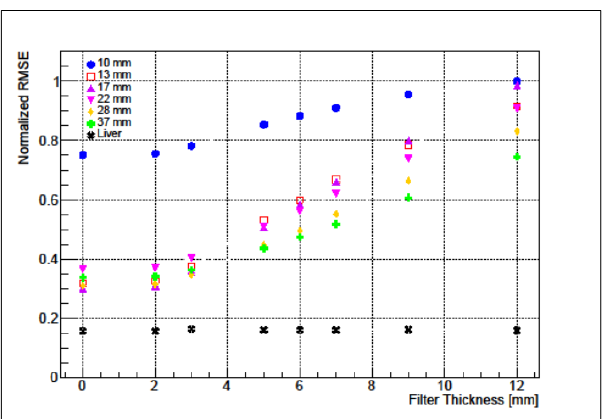
Figure 6. Normalized RMSE for the liver (black) and for the IEC NEMA spheres as a function of the Gaussian filter.